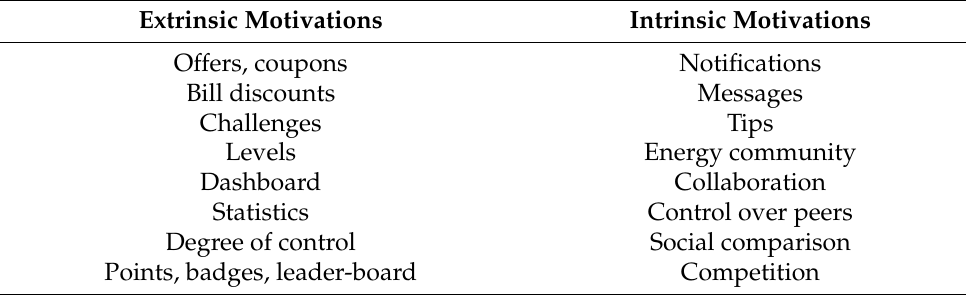
Table 1. Gamification elements for extrinsic and intrinsic